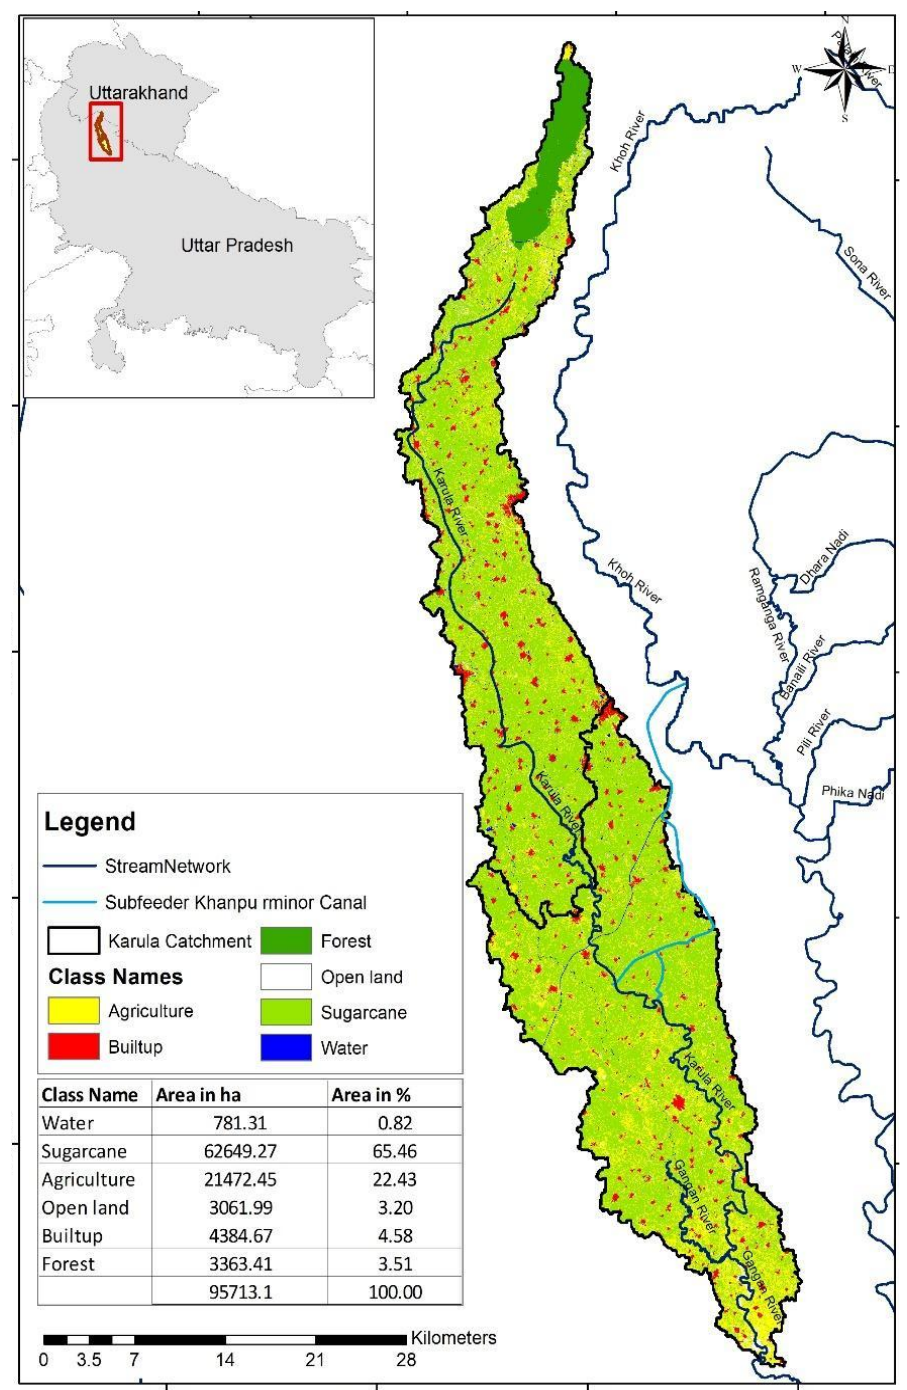
Figure A3. Land ‐ use & Land ‐ cover Map of Karula River Basin. Figure A2. Land-use & Land-cover Map of Karula River